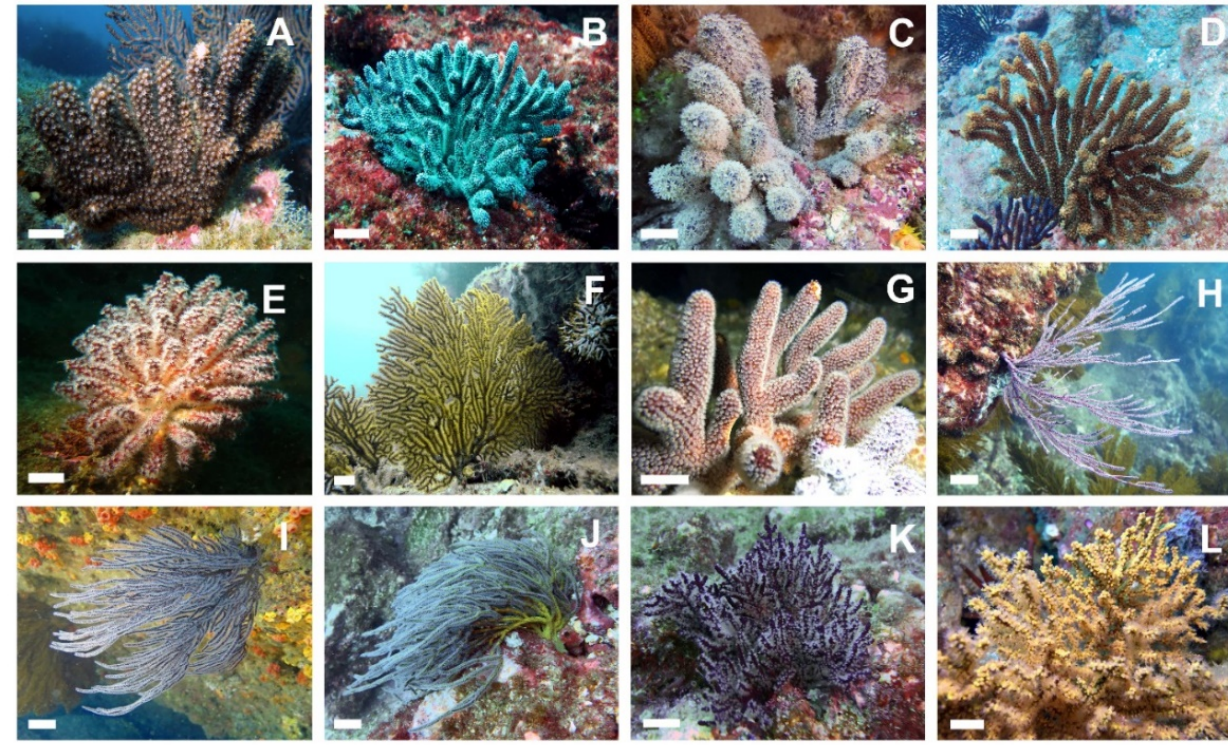
Figure 2. In situ images of 12 octocorals studied at the Equatorial Front. ( A ) Muricea squarrosa , ( B ) M. purpurea , ( C ) M. austera , ( D ) M. crassa , ( E ) M. fruticosa , ( F ) M. plantaginea , ( G ) M. hebes , ( H ) Lepto- gorgia alba , ( I ) L. cf. alba , ( J ) L. cuspidata , ( K ) L. obscura , and ( L ) L. pumila . The scale bar represents 1 cm.